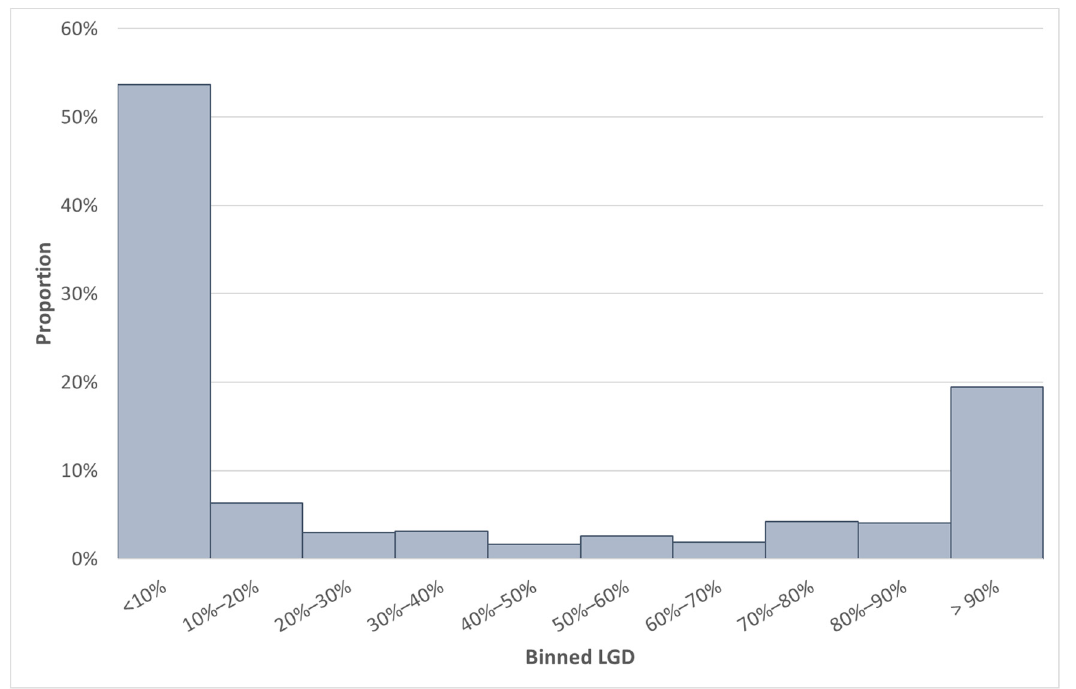
Figure 4. Distribution of LGD of the build data set (Data set BB) used in case study 2. Step 2: Build a model on Data set BB (Base Build).